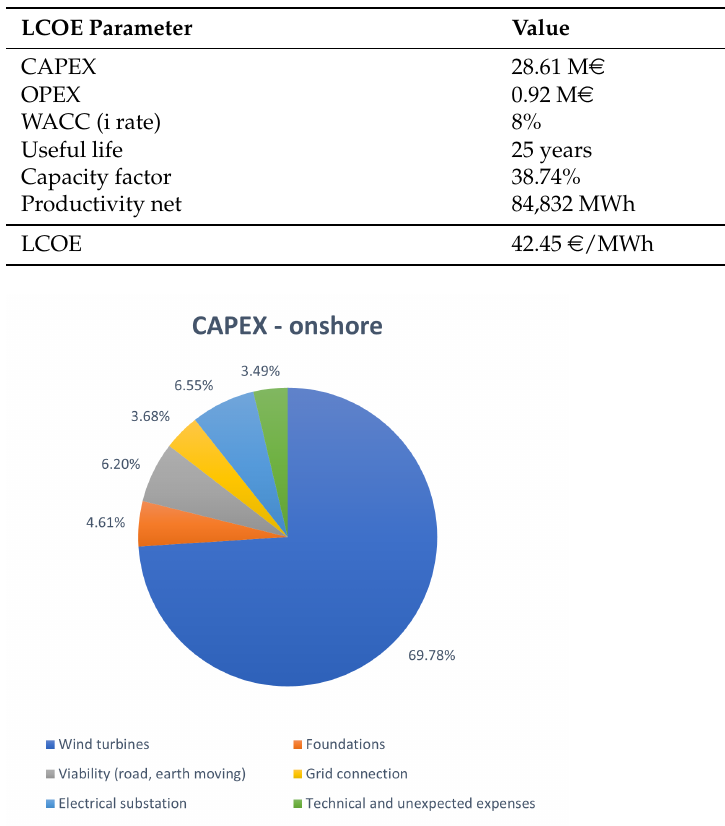
Table 8. LCOE internal parameters for an onshore turbine.